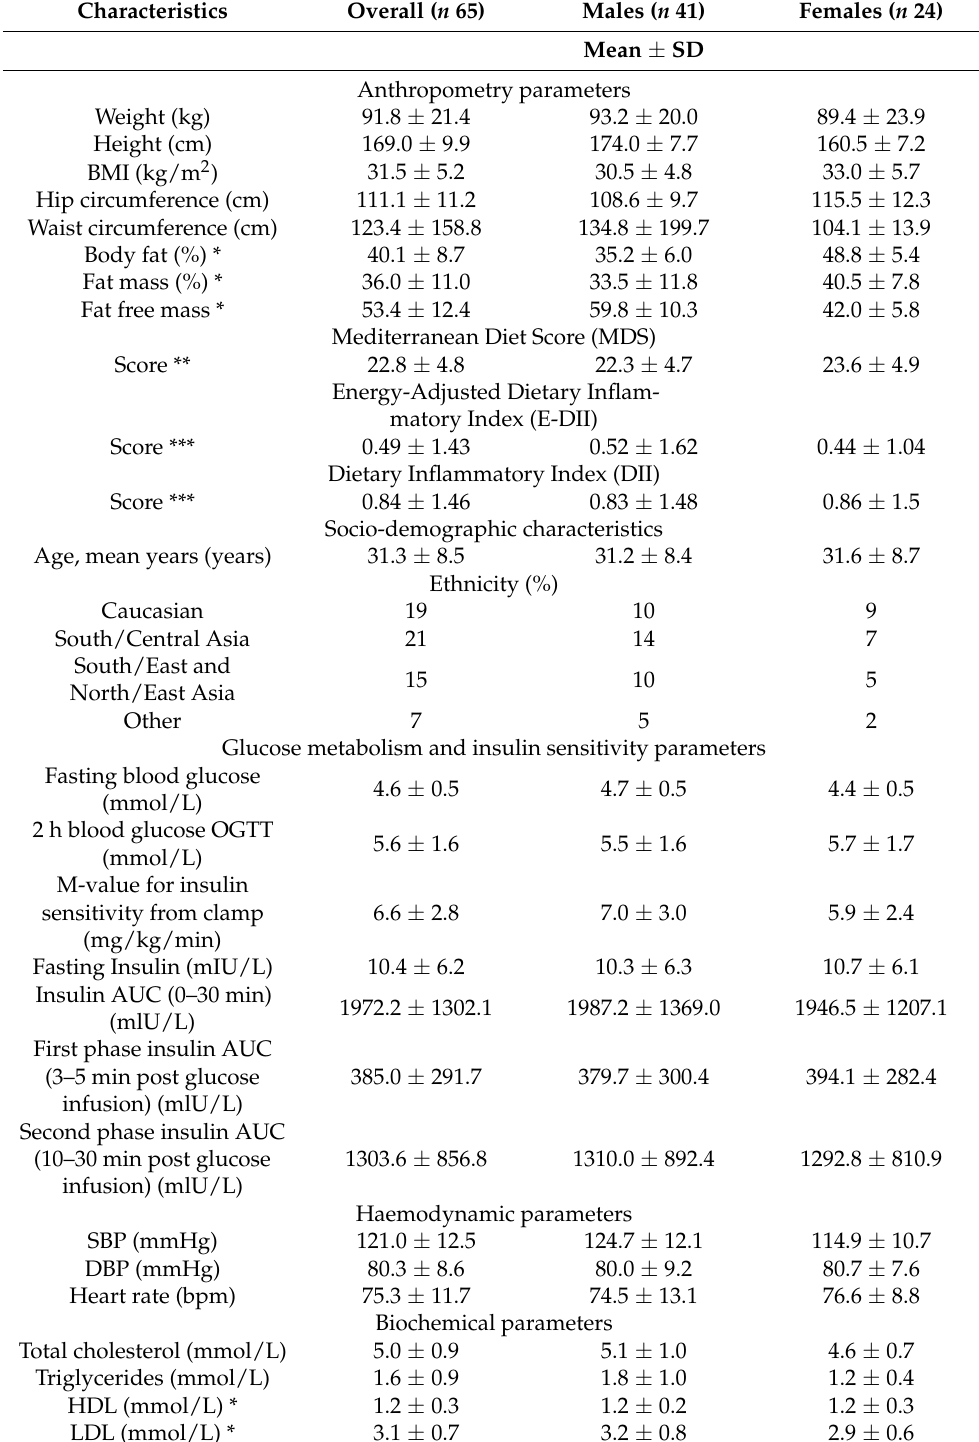
Table 1. Lifestyle, clinical and biochemical baseline characteristics of the study participants 1 .